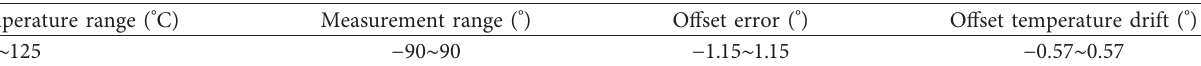
Figure 3: Photograph of the inclinometers and data acquisition and transmission devices. Table 1: General specifications of the SCL3300-D01 3-axis